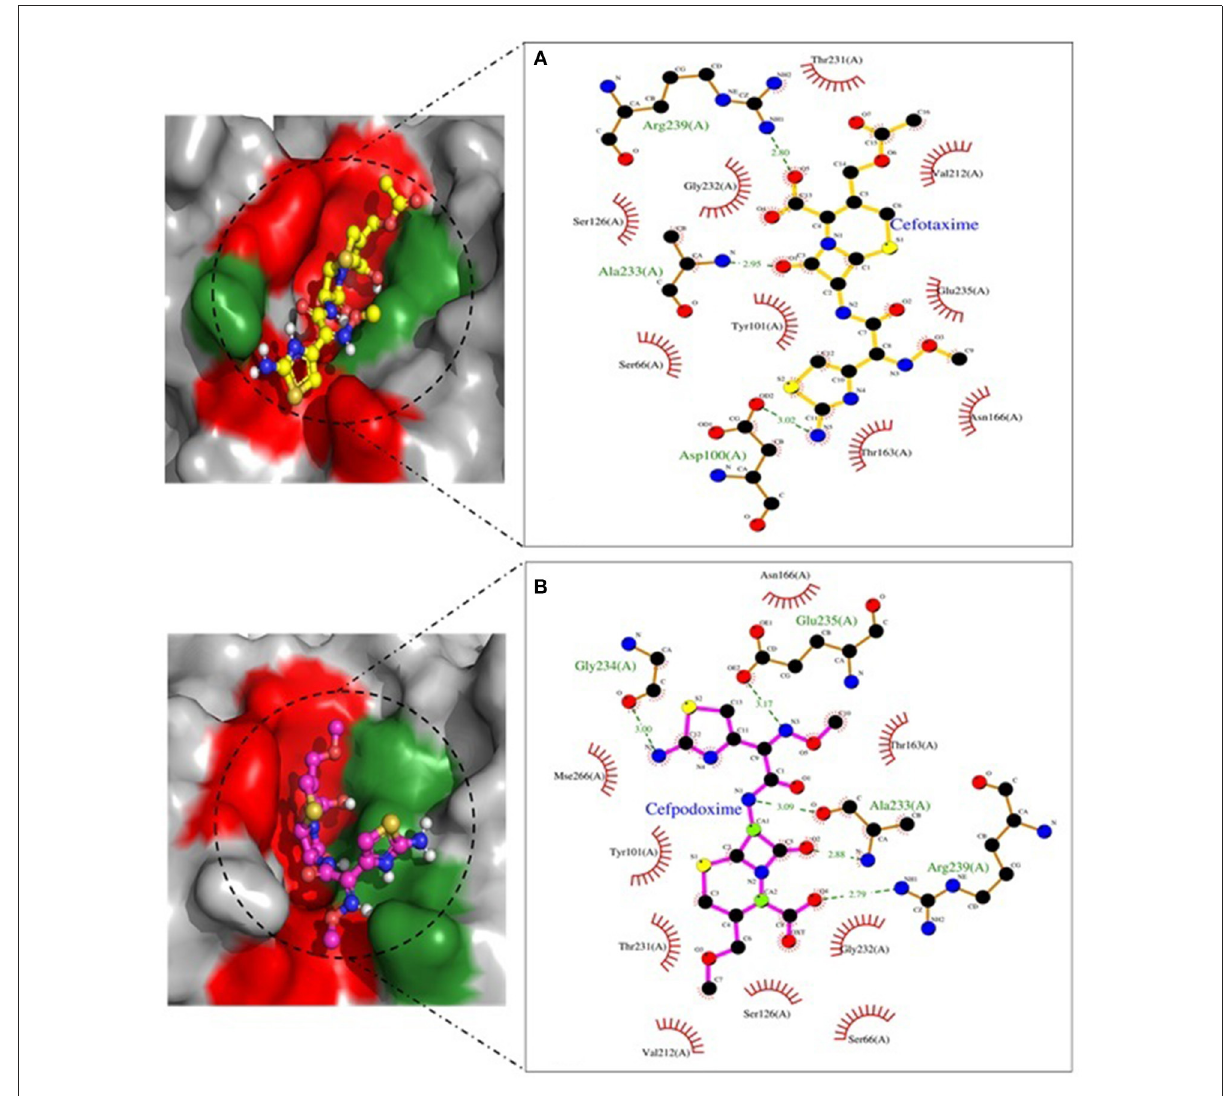
FIGURE7 SHV-11 involved in interactions. (A) A binding map for cefotaxime + SHV-11. (B) A binding map for cefpodoxime +